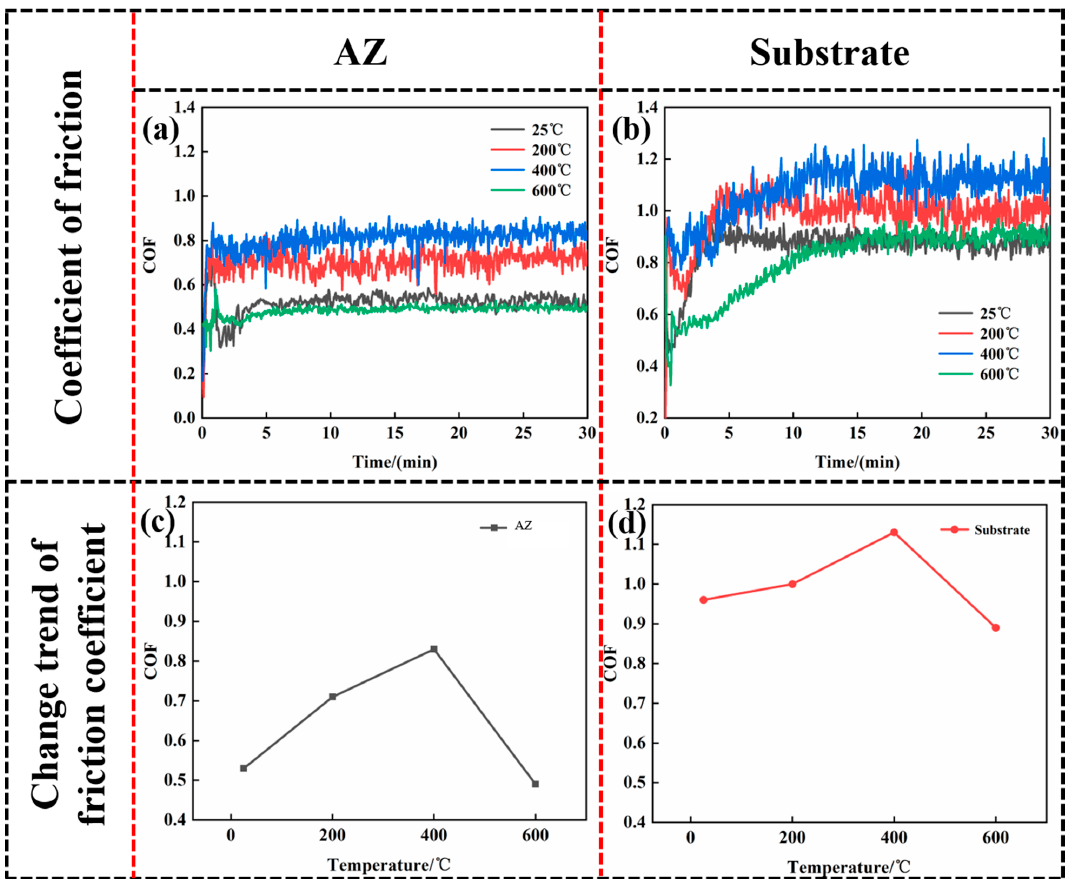
Figure 4. Coefficient of friction of AZ and substrate under different temperature environments: ( a ) Coefficient of friction of AZ, ( b ) Coefficient of friction of substrate, ( c ) Variation trend of average coefficient of friction of AZ, ( d ) Variation trend of average coefficient of friction of substrate.